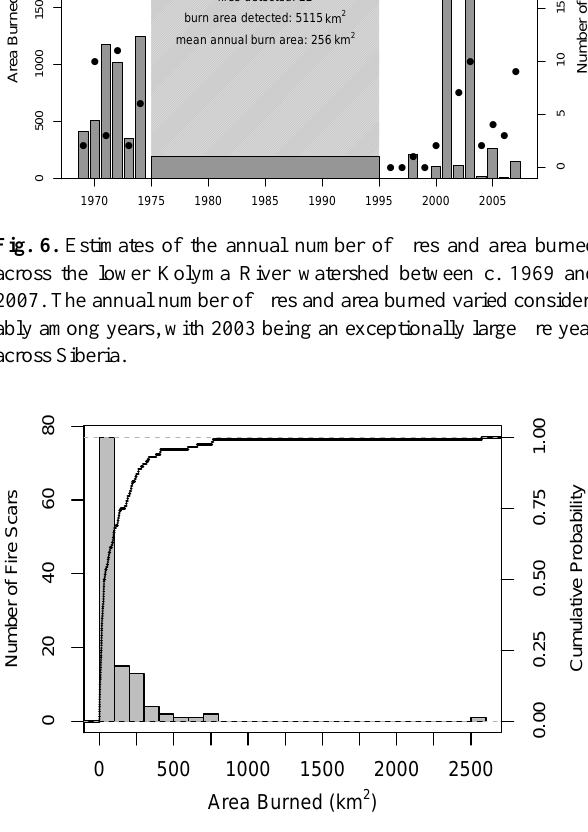
Fig. 7. Frequency and empirical cumulative distribution function plots of fire scar size. Fires were generally quite small, with 75% smaller than 150km 2 and 5% greater than 400km 2